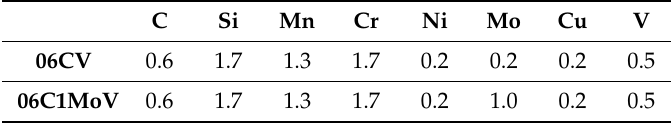
Table 1. Chemical analysis (in wt %) of the steels used for this